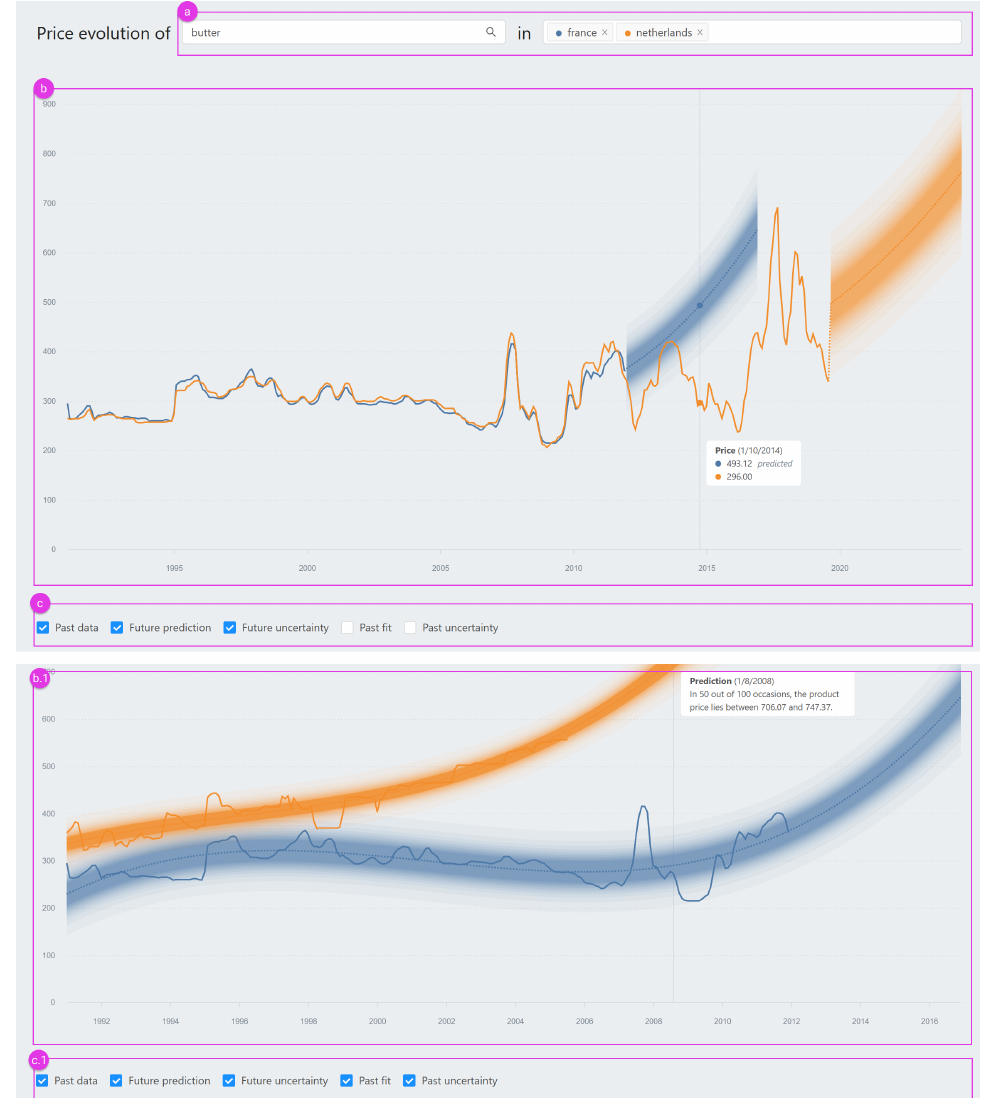
Figure 10. Interface for uncertainty-aware price prediction: ( a ) toolbar; ( b ) price data for the product and countries selected in toolbar; ( c ) visualisation